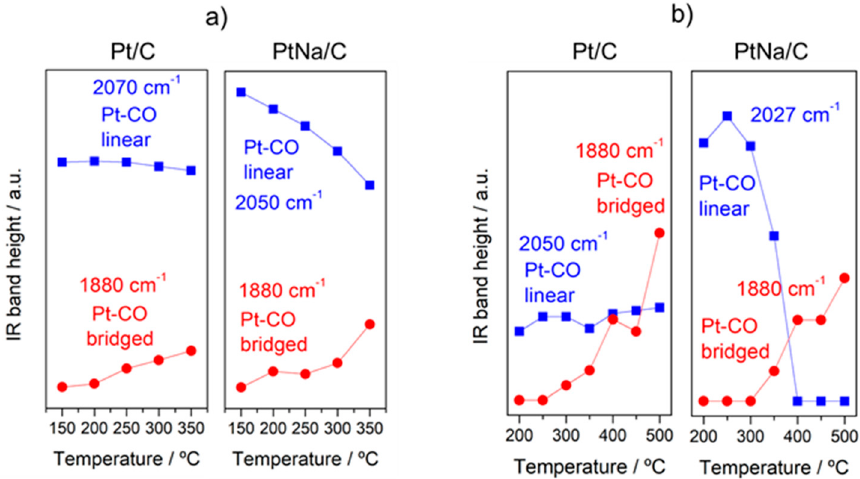
Figure 8. Evolution of the IR band height associated to Pt–CO linear and Pt–CO bridged species as a function of the temperature during the ( a ) WGS and ( b ) rWGS reaction for the Pt/C and Pt–Na/C catalysts, respectively.